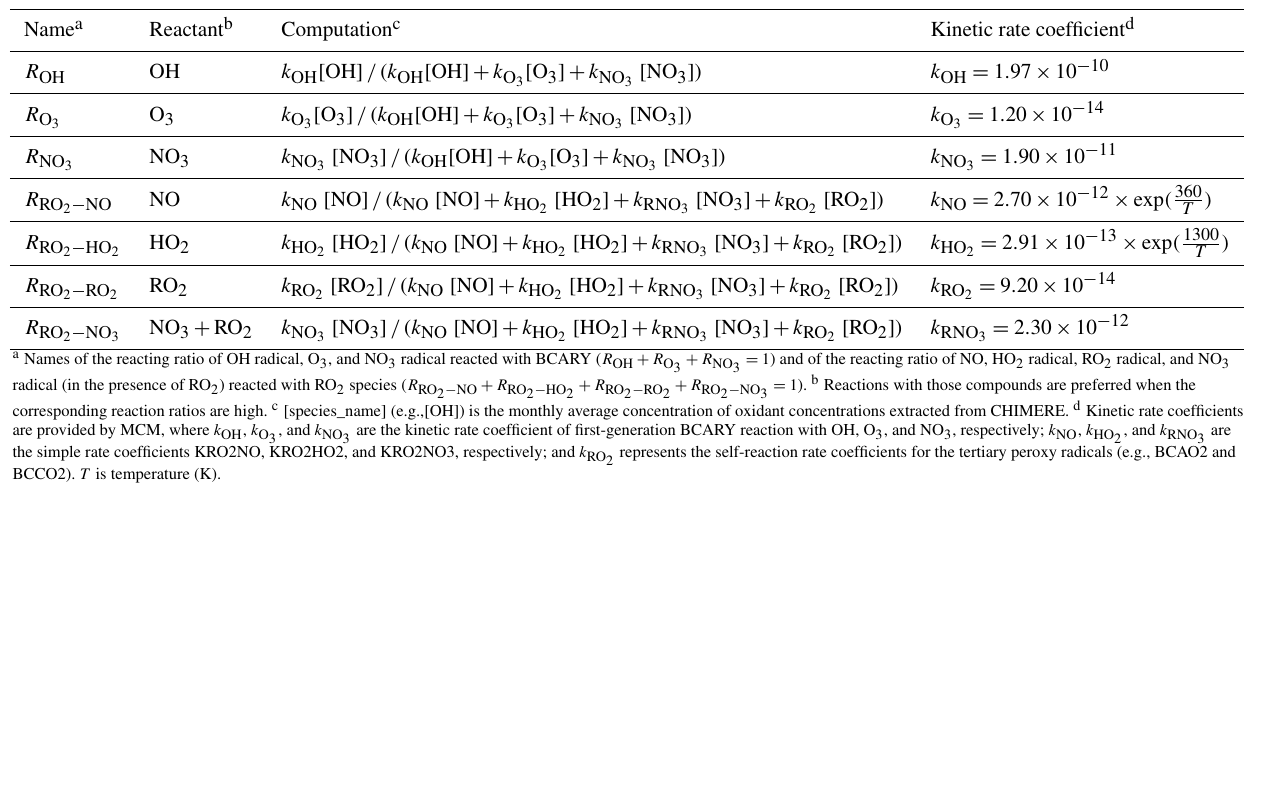
Table C1. The computation of estimating chemical activity ratios used to display training dataset in Fig.